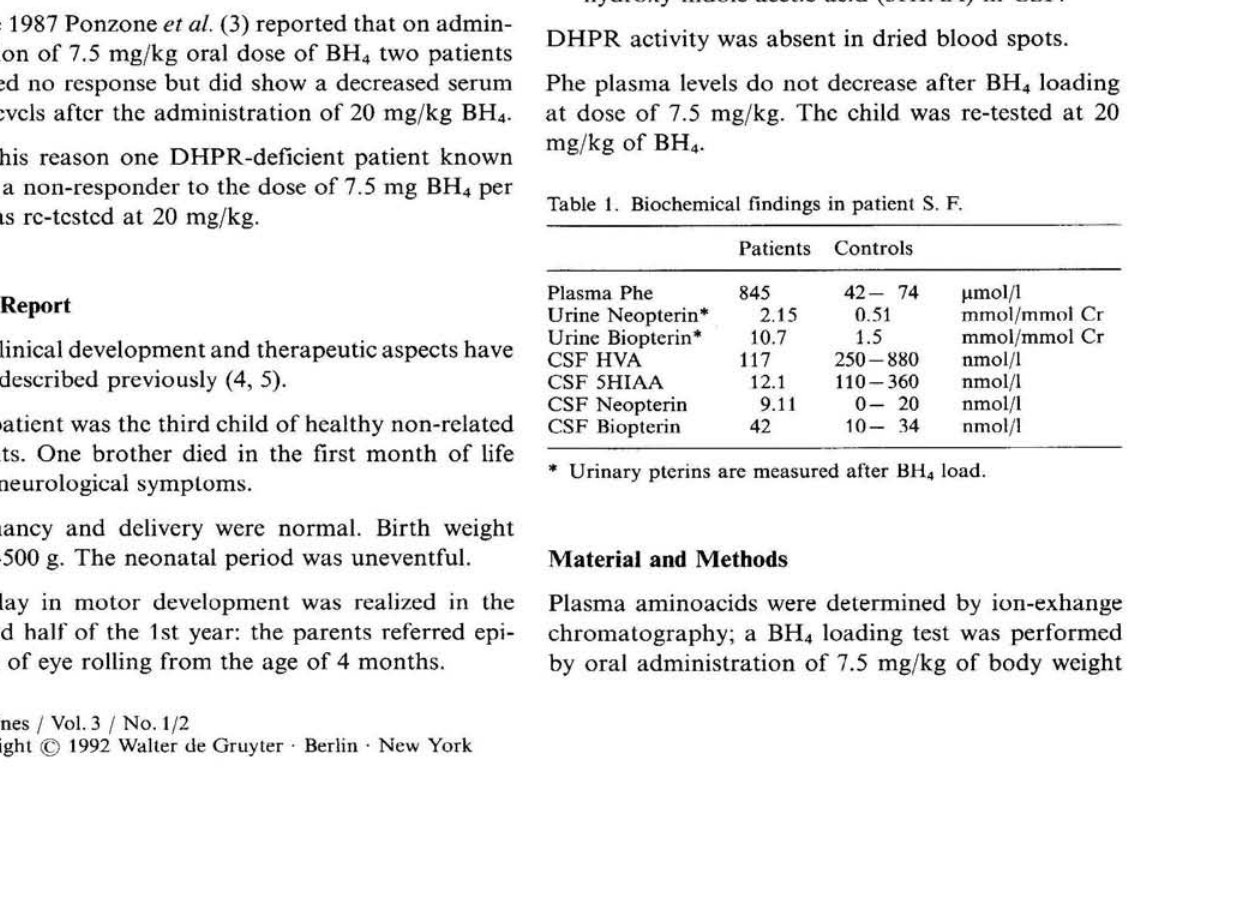
Table 1. Biochemical findings in patient S.